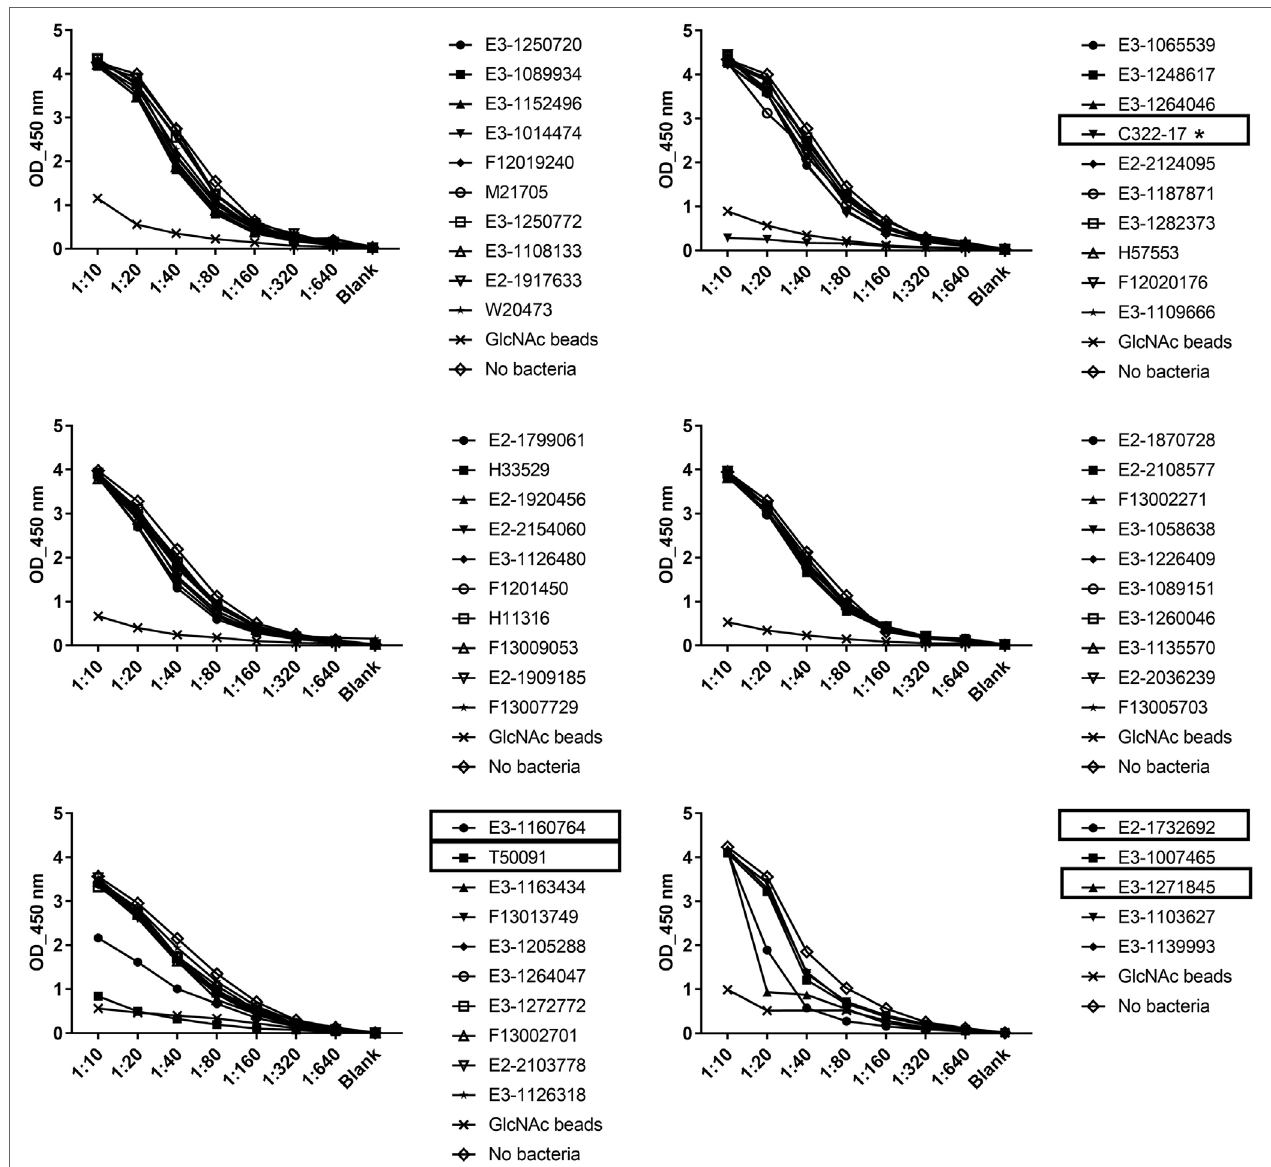
FigUre 2 | Consumption of serum ficolin-2 by 56 clinical Enteroaggregative Escherichia coli (EAEC) isolates. 56 clinical EAEC isolates and a control containing GlcNAc beads were incubated with 10% normal human serum and the unbound protein fraction was transferred to ELISA plates coated with acetylated bovine serum albumin, in twofold serial dilutions. Specific mAb were used to detect ficolin-2. Boxes show isolates binding ficolin-2 and * marks isolate C322-17 showing high binding of